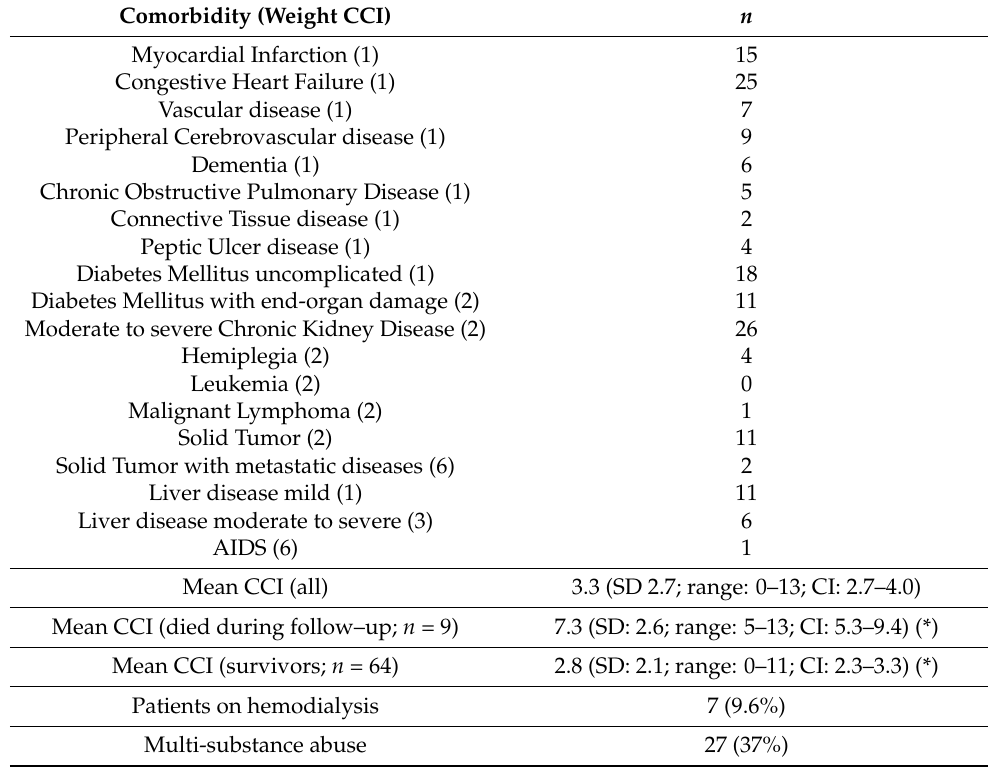
Table 5. Comorbidities classified according to the Charlson Comorbidity Index (CCI); (*) Student’s t -test: p =